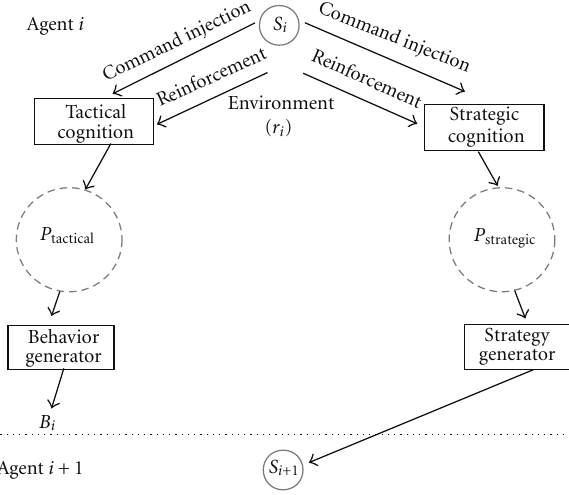
Figure 9: The combined tactical and strategic hierarchical learning framework. The tactical behavior and its strategy for the agents in the current hierarchical level is governed by the strategy being generated from the commander agents in the previous hierarchical level. Central to the framework are the adaptive tactical and strategic personalities which control the selection process for the behaviors and strategies for each